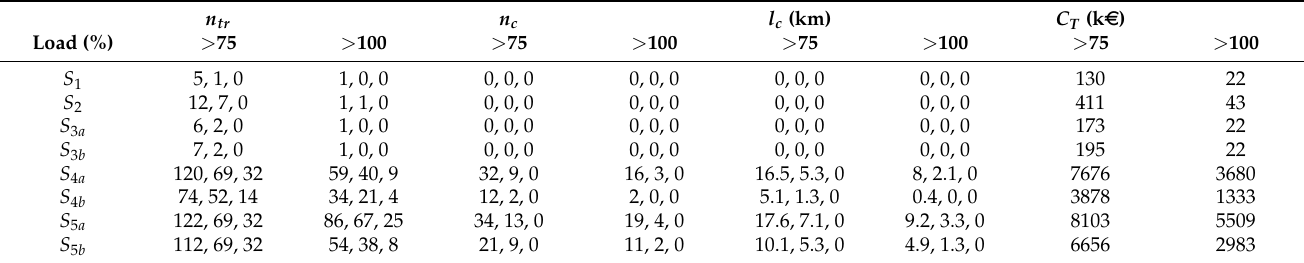
Table 6. Summary of reinforcement costs required to match the increased load in each scenario S i . We indicate the number of transformers n tr ≡ n 1 length l c ≡ l 1 c , l 2 c , l 3 c (km) per PDN in Frederiksberg that exceed 75% and 100% of the nominal capacity. The last column contains an estimate for the total costs C T (k e ) associated with the respective